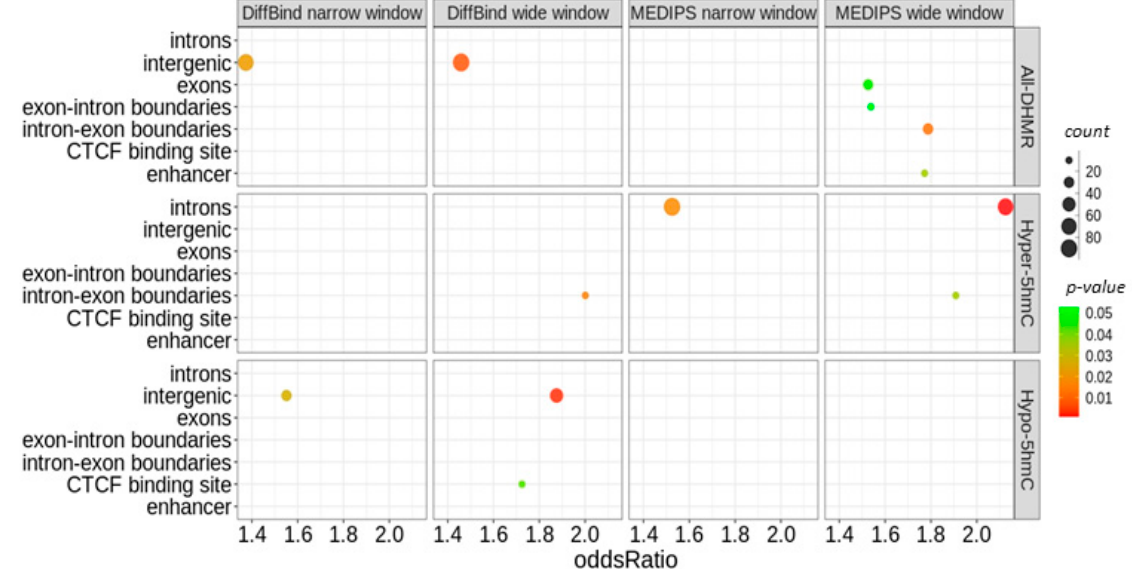
Figure 8. Enrichment analysis of age-associated differentially hydroxymethylated regions (DHMRs). The statistical analysis was performed with Fisher’s exact test and the LOLA package. Results are presented for p -values without the false discovery rate (FDR) correction.